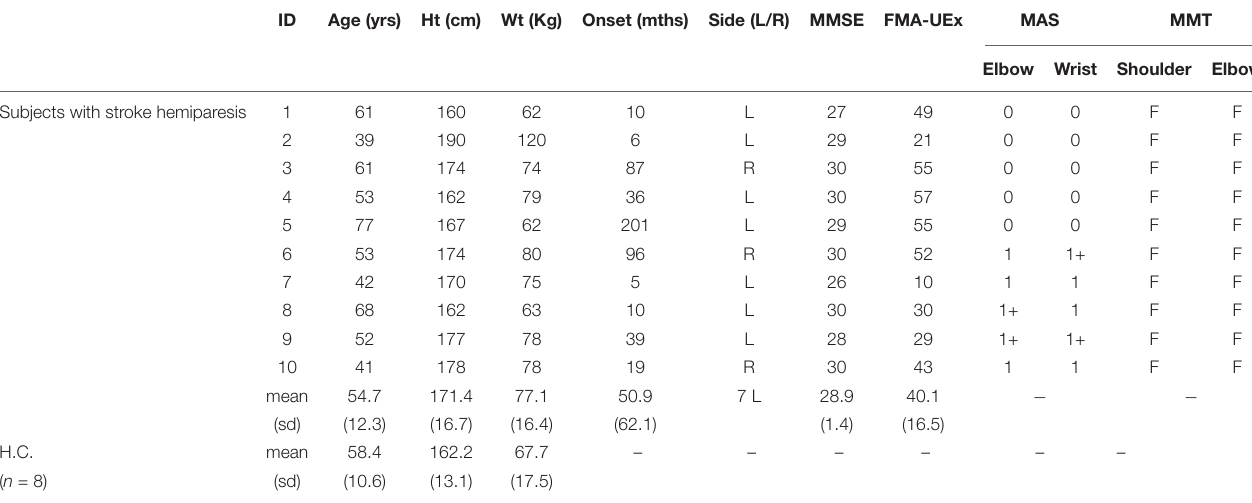
Elbow Wrist Shoulder Elbow